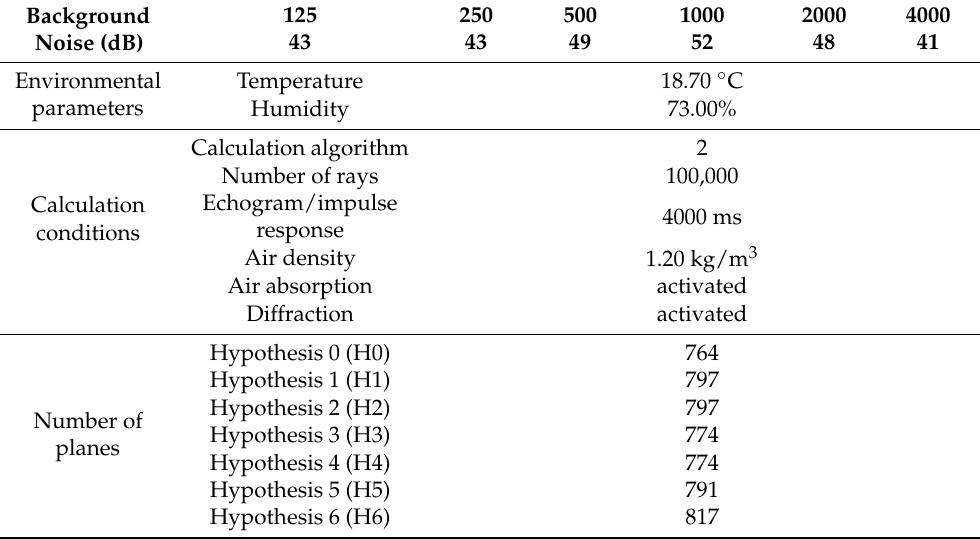
Table 2. Calculation conditions.